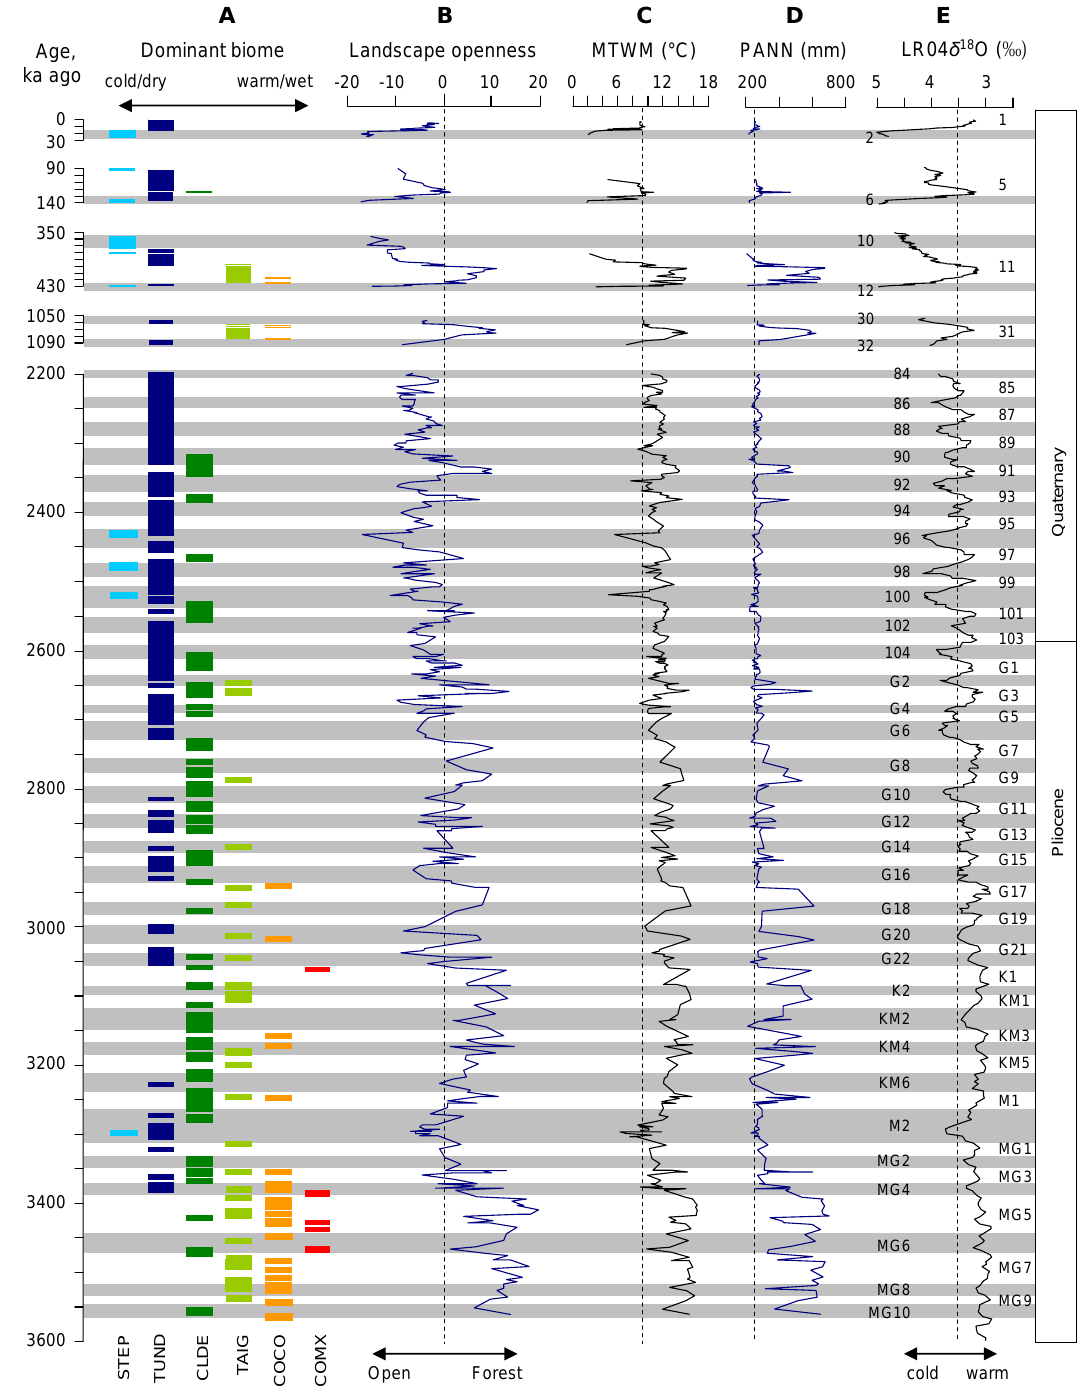
Fig. 7. Summary of paleoenvironmental trends between ∼ 3580 and ∼ 2200ka ago showing the (A) time series of the dominant vegetation types (biomes); (B) characteristic of landscape openness calculated as the difference between the maximum score of the forest biomes (MSFB) and the maximum score of the open biomes (MSOB) at each level; (C) pollen-based reconstructions of the mean temperature of the warmest month; (D) pollen-based reconstructions of mean annual precipitation (after Melles et al., 2012; Brigham-Grette et al., 2013); and (E) Pliocene–Pleistocene stack of 57 globally distributed benthic δ 18 O records with marine isotope stage (MIS) numbers (after Lisiecki and Raymo, 2005). Grey and white bands indicate cold and warm marine isotope stages, respectively. Biome names are abbreviated as follows: STEP – cold steppe, TUND – tundra, CLDE – cold deciduous forest, TAIG – taiga, COCO – cool conifer forest, and COMX – cool mixed